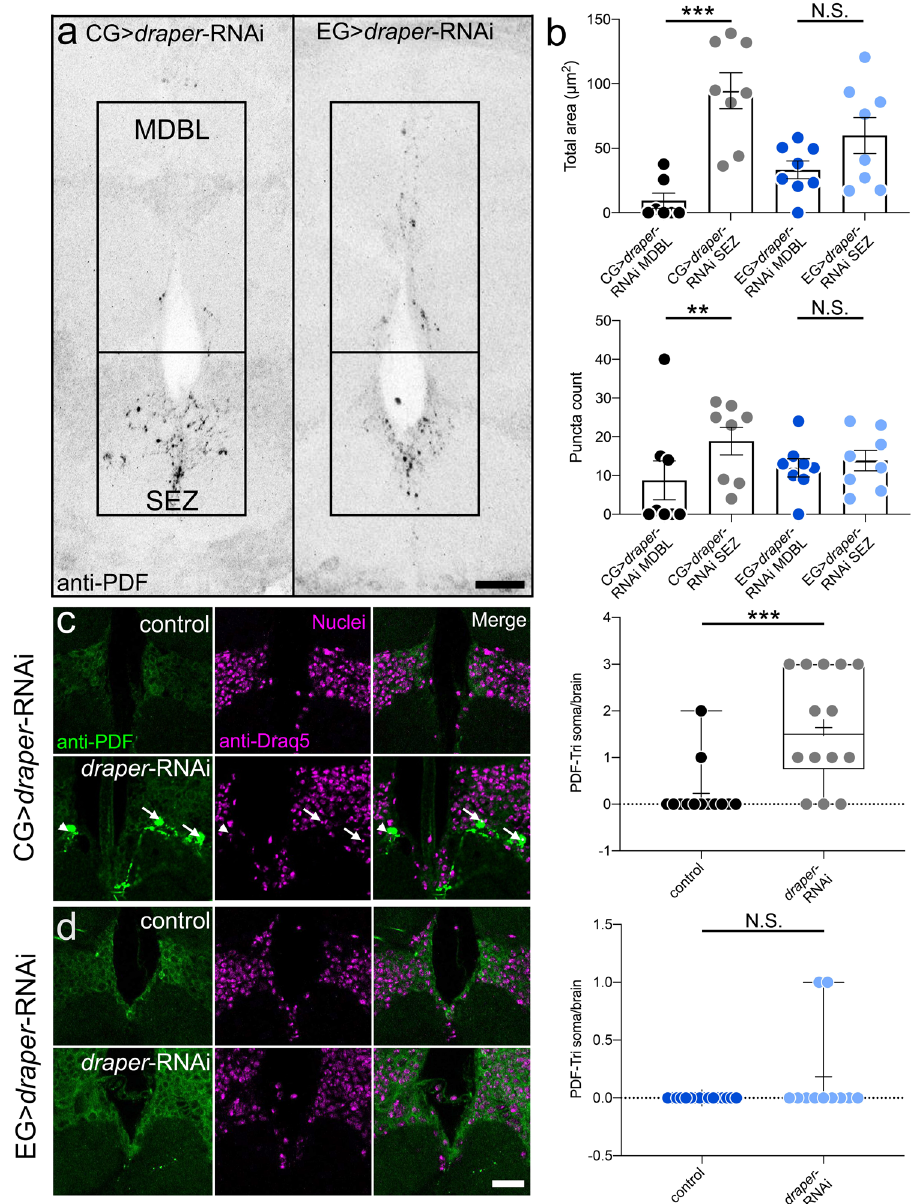
Fig. 4 Cortex and ensheathing glia clear PDF-Tri neurons in spatially restricted domains. a Brain midline labeled with anti-PDF at 5 DPE with cortex glia- driven draper- RNAi (CG, R54H02 -Gal4 > draper -RNAi, left) or ensheathing glia-driven draper- RNAi (EG, R56F03 -Gal4> draper -RNAi, right). Boxed regions are the distal medial bundle (MDBL) or proximal subesophageal zone (SEZ). Scale bar: 25 μ m. Images are representative of two independent experiments. b Quanti fi cation of anti-PDF area (top) or puncta (bottom) comparing MDBL and SEZ with CG > draper -RNAi (left, black/gray) and EG > draper -RNAi (right, blue/light blue). Area: CG > draper -RNAi, Two-sided Mann – Whitney, p = 0.0006, 26.61 ± 17.89 n = 7 MDBL, 94.62 ± 13.93 n = 8 SEZ. EG > draper - RNAi, Two-sided t test, p = 0.1084, 33.33 ± 6.844 n = 8 MDBL, 59.89 ± 13.89 n = 8 SEZ. Puncta: CG > draper -RNAi, two-sided Mann – Whitney, p = 0.0079, 4.28 ± 2.643 n = 7 MDBL, 18.88 ± 3.573 n = 8 SEZ. EG > draper -RNAi, Two-sided t test, p = 0.6049, 12.00 ± 2.360 n = 8 MDBL, 13.88 ± 2.642 n = 8 SEZ. c Brain slices from 5 DPE control (CG, R54H02 -Gal4/ + , top) and draper- RNAi (CG, R54H02 -Gal4 > draper -RNAi) labeled with anti-PDF (green, left), nuclear anti-Draq5 (magenta, middle) and merge (left). Arrows indicate colocalized ant-PDF and -Draq5 (PDF-Tri soma). Arrowhead indicates PDF-Tri neuron slightly out of plane. Right: Quanti fi cation of PDF-Tri neuron cell bodies per brain. Two-sided Mann – Whitney, p = 0.0009, 0.2308 ± 0.1662 n = 13 control, 1.643 ± 0.3249 n = 14 draper -RNAi. d Brain slices from 5 DPE control (EG, R56F03 -Gal4/ + , top) and draper- RNAi (EG, R56F03 -Gal4 > draper -RNAi) labeled with anti-PDF (green, left), nuclear anti-Draq5 (magenta, middle) and merge (left). Scale bar: 25 μ m. Right: Quanti fi cation of PDF-Tri neuron cell bodies per brain. Two-sided Mann – Whitney, p = 0.1567, 0.000 ± 0.000 n = 16 control, 0.1818 ± 0.1220 n = 11 draper -RNAi. Scatter plots show mean ± SEM. Box and whisker plots show quartiles with max and min values, with plus sign indicating the mean. Sample size is n = number of animals. Signi fi cance: p > 0.05 (not signi fi cant N.S.), p < 0.01 (**), and p < 0.001 (***). Source data for this fi gure are provided in Source Data fi le.